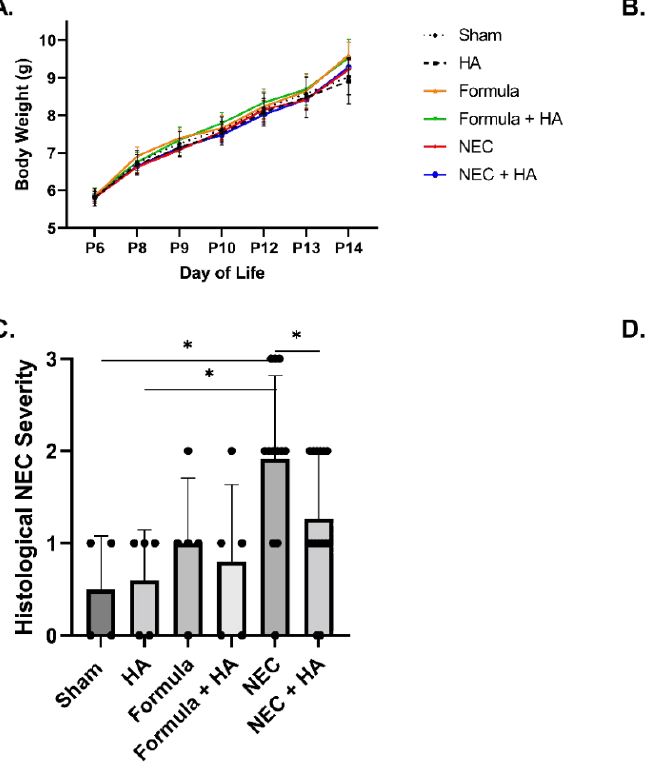
Figure 1. Pretreatment with oral HA35 for 7 days protects against NEC morbidity and mortality. ( A ) HA35 did not affect weight gain among treatment groups ( p = 0.9972; n ≥ 5/group). ( B ) HA35 treatment trended toward increased survival during the 13 h experiment, from approximately 67% (untreated NEC; n = 18) to 88% (NEC + HA; n = 17; p = 0.1209). ( C ) HA35 reduced intestinal histological injury compared to untreated NEC ( n = 12 (NEC) and 15 (NEC + HA); 1.917 vs. 1.297; p = 0.0452). ( D ) Representative histology of sham, HA, formula, formula + HA, NEC, and NEC + HA pups. Data are presented as the mean ± SEM, * p < 0.05. HA: hyaluronic acid; NEC: necrotizing enterocolitis; SEM: standard error of the